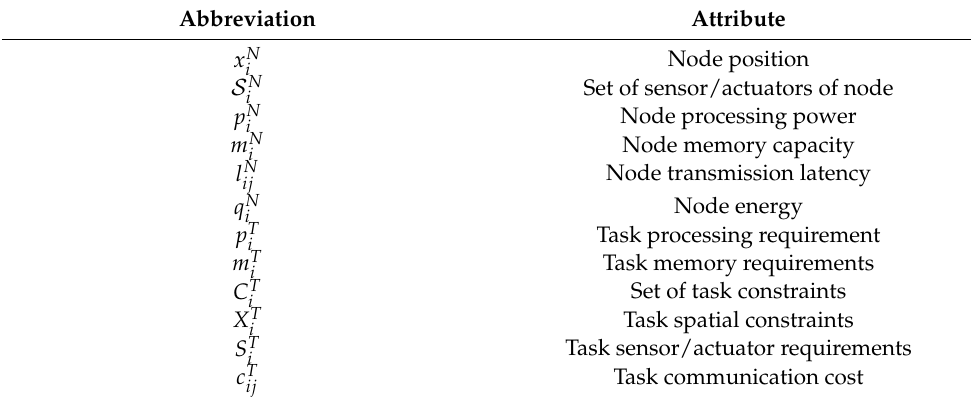
Table 1. Full List of Node and Task Attributes.